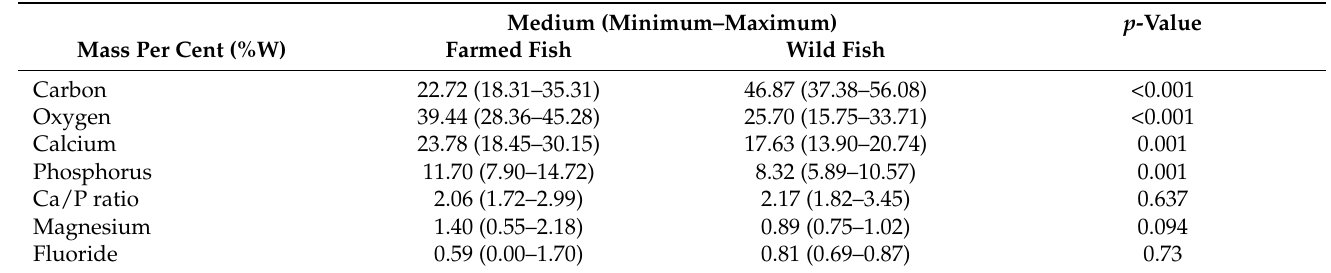
Table 3. Semi-quantitative elemental microanalysis in teeth of rainbow trout ( Oncorhynchus mykiss ) by SEM-EDX.